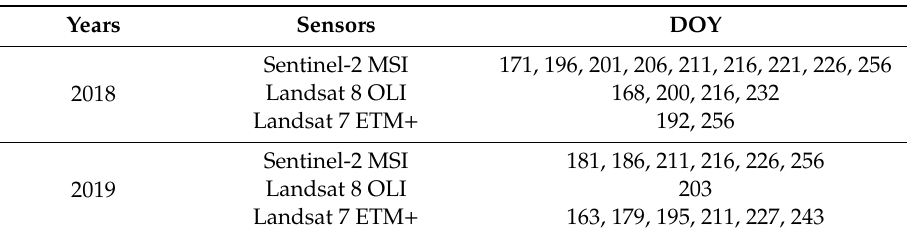
Table 1. Acquisition dates of remote-sensing (RS) data collected over the study area for 2018 and 2019. DOY stands for day of